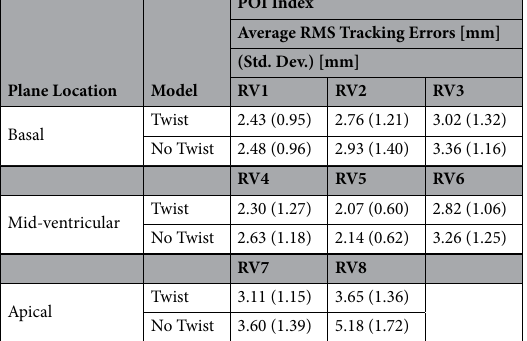
Table 6. The summary of the results for the 8-point RV model. The averages and standard deviations of RMS tracking errors across the eight Cine MR datasets are given. Results are shown with and without the twisting in the deformable